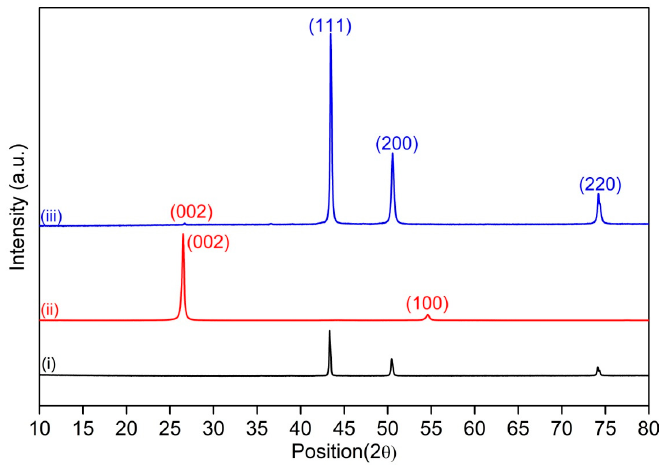
Figure 5. X-ray diffraction pattern of (i) pure copper, (ii) as-received GNPs, and (iii) Cu–8 vol % GNPs after sintering at 950 °C for 2.5 h.